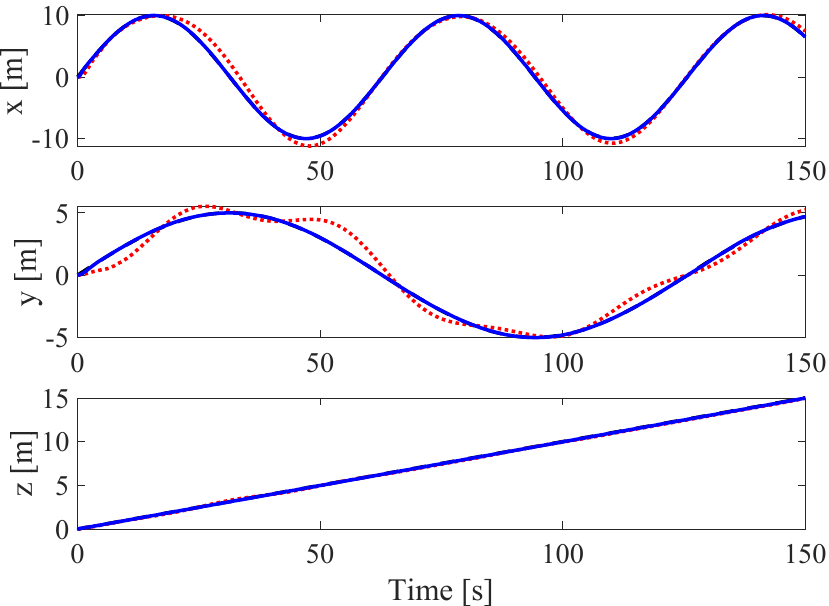
Figure 6. Position control response of two motion control systems. The red dotted line is PID control; the solid blue line is SMC; the black dashed reference trajectory line along the z -direction is z d = 0.1 t 0.1 .